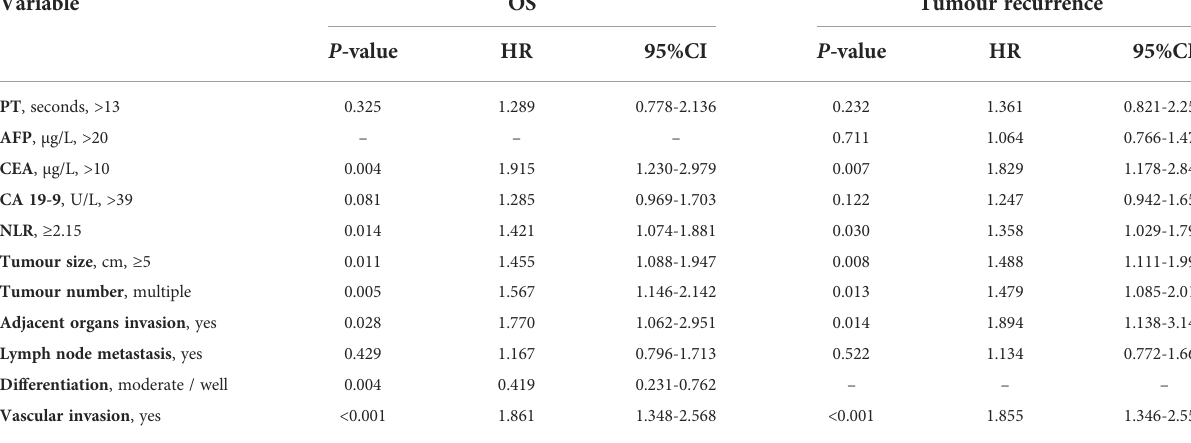
TABLE 7 Multivariate analysis of prognostic factors in ICC patients with HBV infection in the PSM cohort.